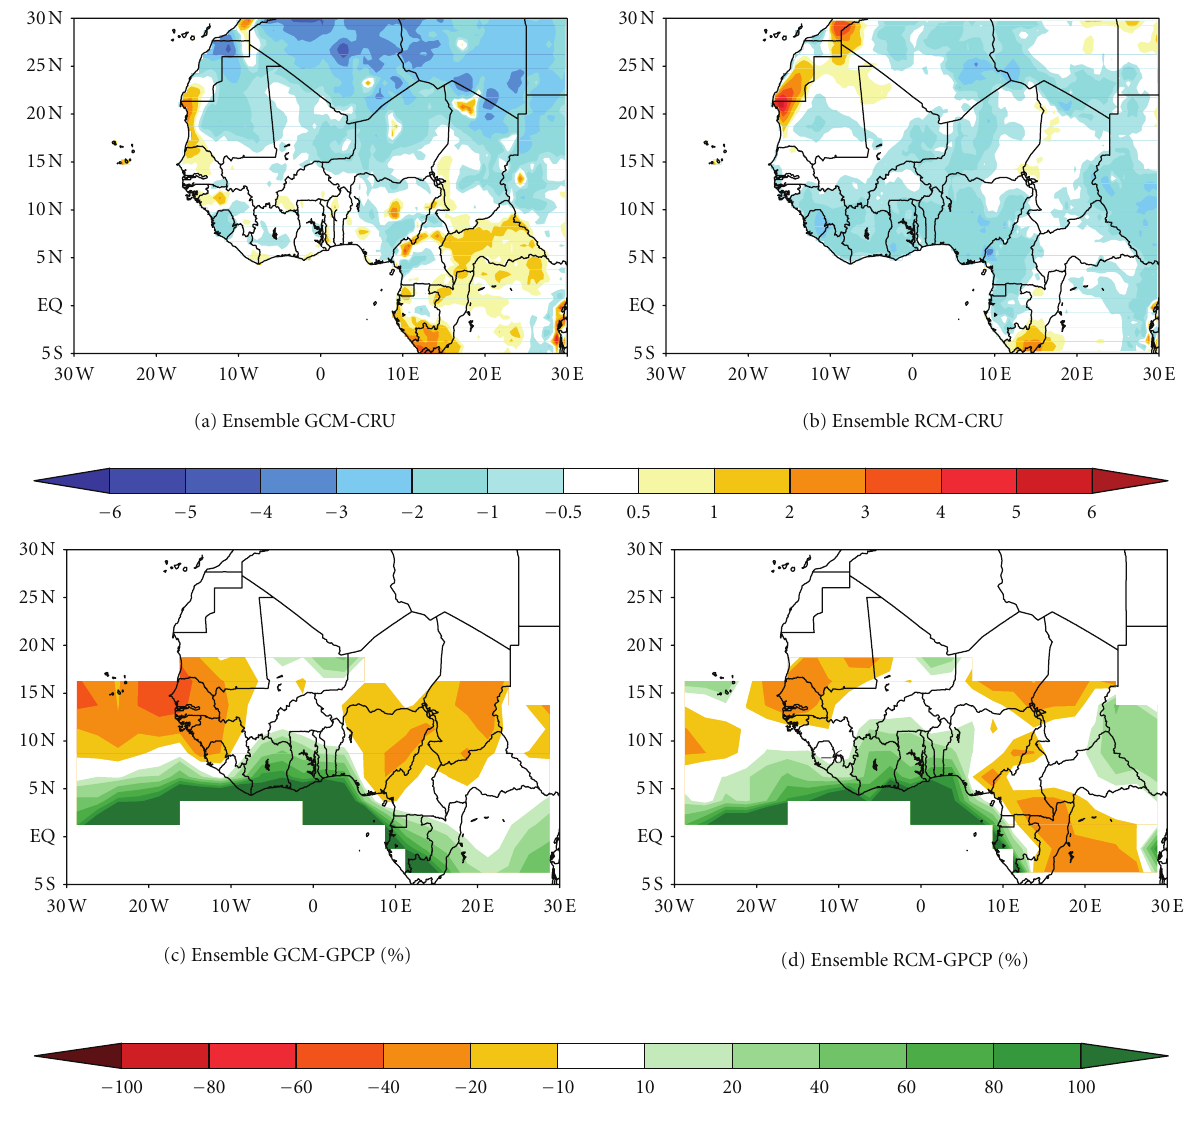
Figure 8: 1981–2000 averaged JJAS bias of temperature (top panel, in ◦ C) from: (a) mean ensemble of GCMs ( ◦ C) and (b) multi-model ensemble of the four RCMs compare with CRU and precipitation bias (bottom panel, in %) from: (c) mean ensemble of GCMs and (d) multi-model ensemble of the four RCMs with respect to GPCP.